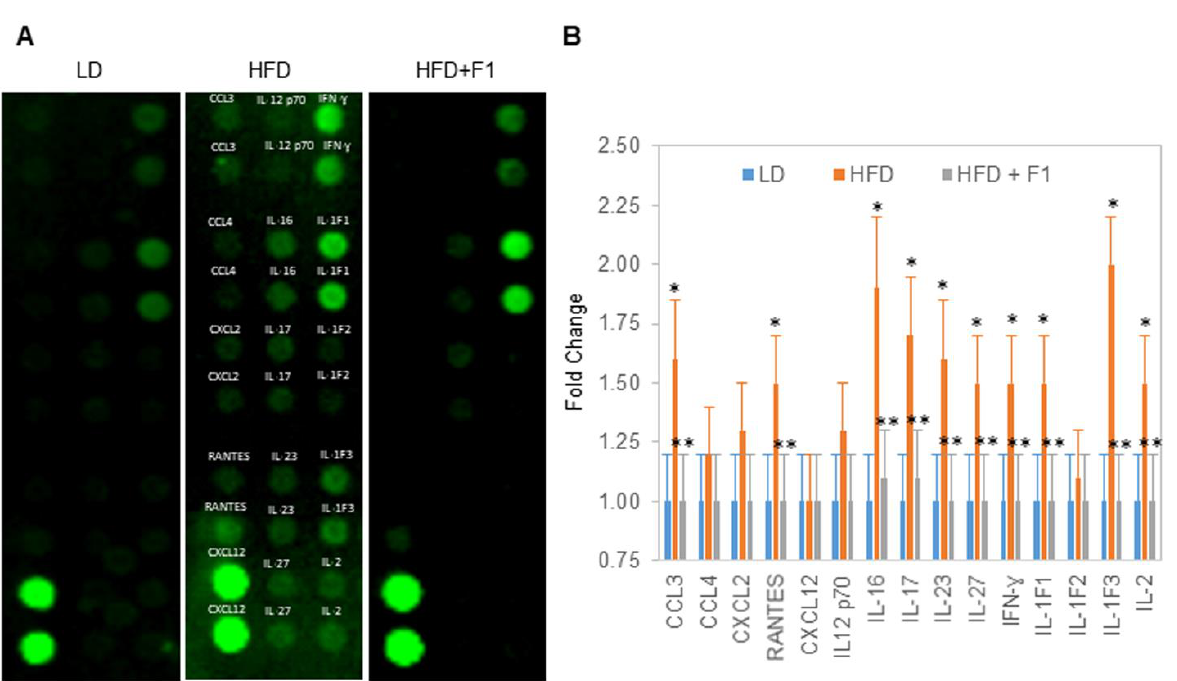
Figure 13. F1 composition reduces systemic inflammation. ( A ) Detection of cytokines and chemokines in the serum of LD (leftmost panel), HFD (middle panel), and HFD + F1 (right panel) animal groups. ( B ) Fold change in the relative abundance of serum cytokines and chemokines in HFD and HFD + F1 animal groups versus LD animal group. Error bars are the standard deviations of forty mice per animal group. Single and double asterisks (*) indicate a statistical significance of a p -value ≤0.01 versus LD and HFD animal groups, respectively.